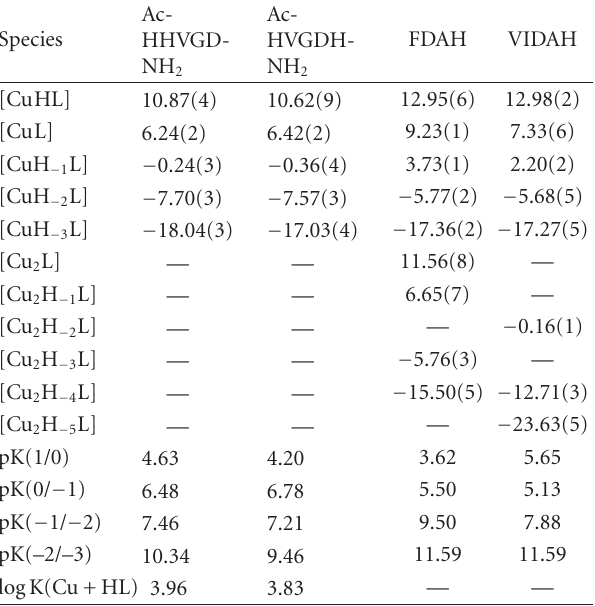
) of the copper(II) complexes pqr